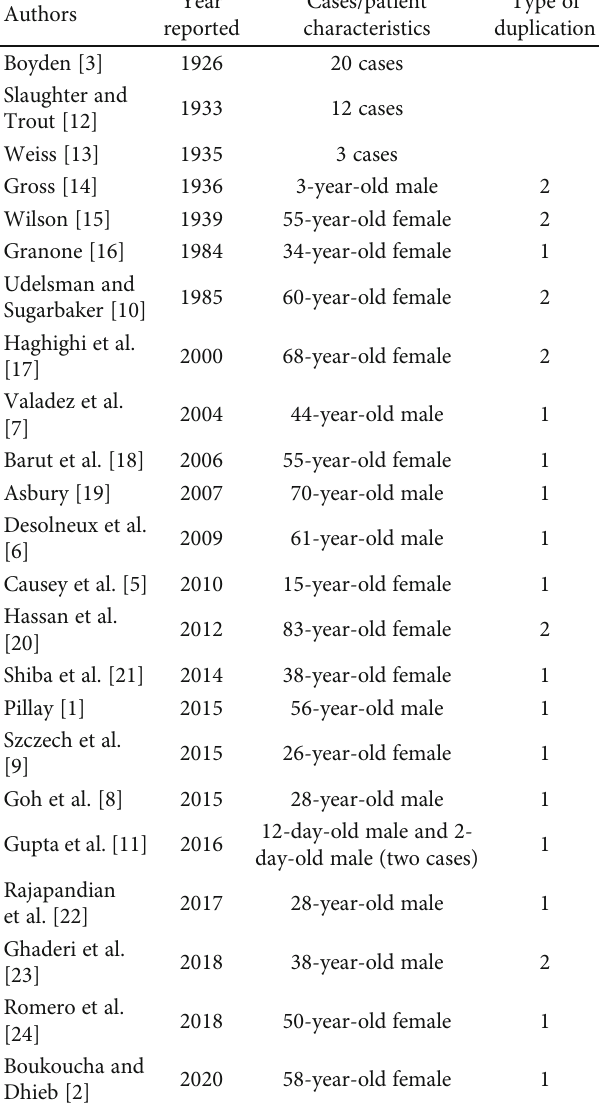
Table 2: Summary of the duplication of gallbladder cases reported since